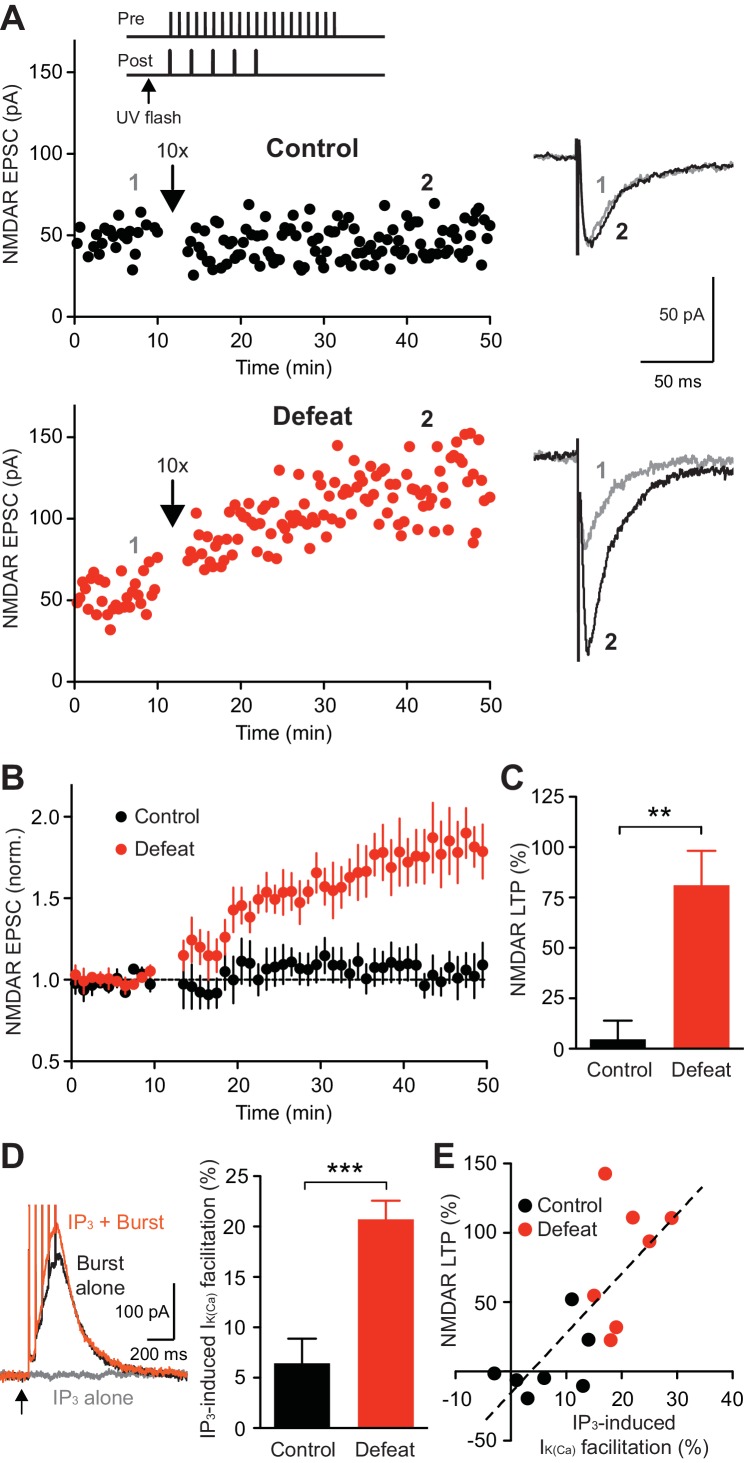
NMDAR-mediated transmission is more susceptible to LTP induction after social defeat.(A) Example experiments to induce NMDAR LTP in neurons from control and defeated rats. Time graphs of NMDAR EPSCs are shown with example traces at times indicated by numbers (baseline: gray, post-induction: black). The LTP induction protocol (IP3-synaptic stimulation-burst combination; illustrated in top inset) was delivered after 10-min baseline recording (at arrow). (B) Summary time graph of baseline-normalized NMDAR EPSCs in LTP experiments (control: 7 cells from 7 rats, defeat: 7 cells from 7 rats). (C) Summary of NMDAR LTP magnitude in control and defeated rats (t12 = 3.93, **p<0.01, unpaired t-test). (D) Example traces (left; from the defeated rat shown in A) and summary (right) of IK(Ca) facilitation by IP3 assessed before LTP induction (t12 = 4.65, ***p<0.001, unpaired t-test). (E) The magnitude of NMDAR LTP is plotted versus the magnitude of IP3-induced facilitation of IK(Ca). Dashed line is a linear fit to all data points from both control and defeated rats.